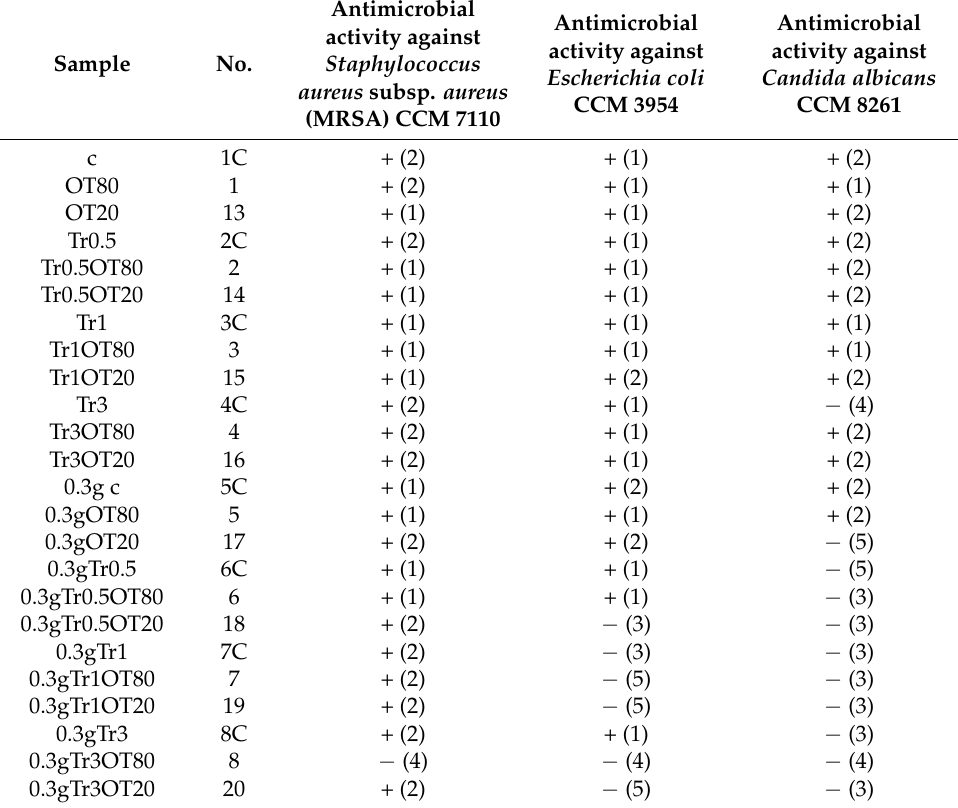
Table 4. Evaluation of antimicrobial activity based on overgrowth of microbial culture over the disc of edible films; evaluation scale 1–5 (1 = disc completely clean, whereas 5 = disc completely overgrown); therefore, + means antimicrobial activity (1,2) and – means no activity (3, 4, 5).